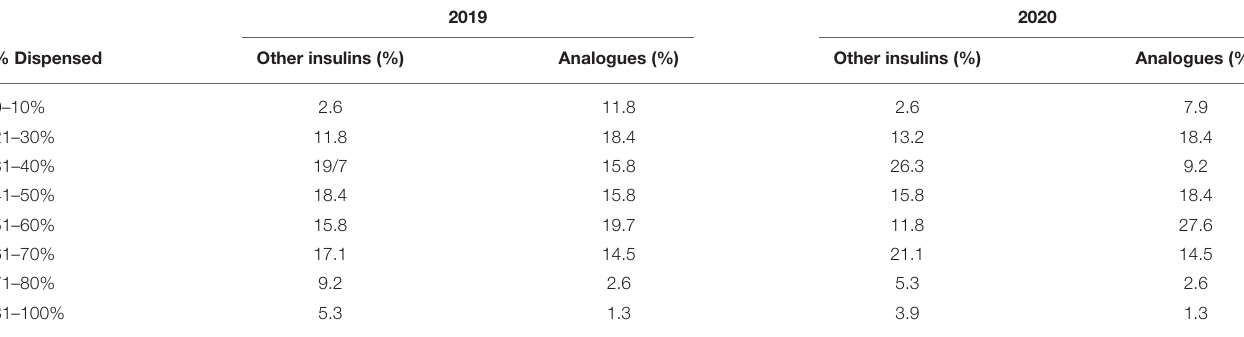
TABLE 4 | Dispensing patterns of different insulin preparations among 76 pharmacies and drug stores in Bangladesh (group